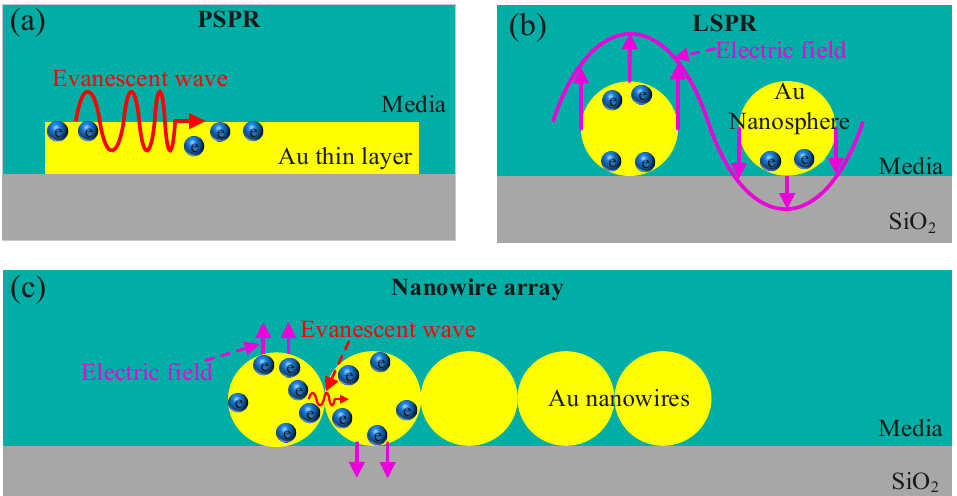
Figure 2. ( a ) PSPR sensing principle; ( b ) LSPR sensing principle; ( c ) Au nanowire group array sensing principle.